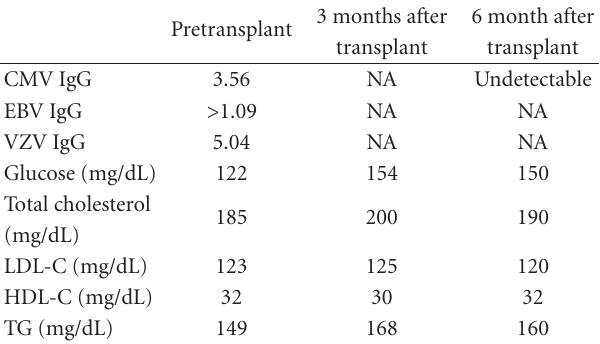
Table 1: Viral titres and lab data before and after transplant. 3 months after 6 month after Pretransplant transplant transplant 3.56